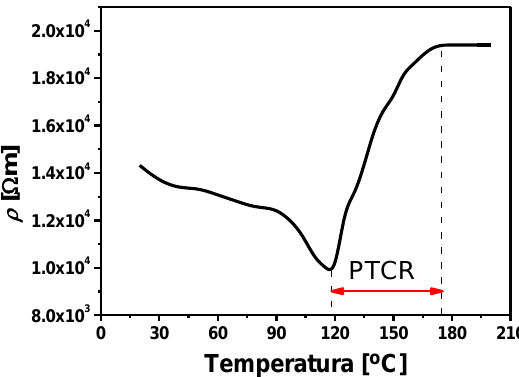
Figure 12. Temperature dependence of resistivity for BLT4 ceramics.